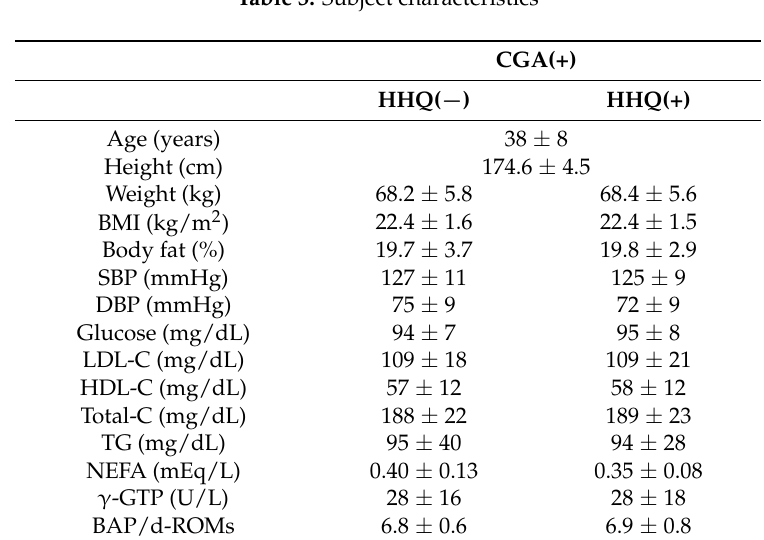
Table 3. Subject